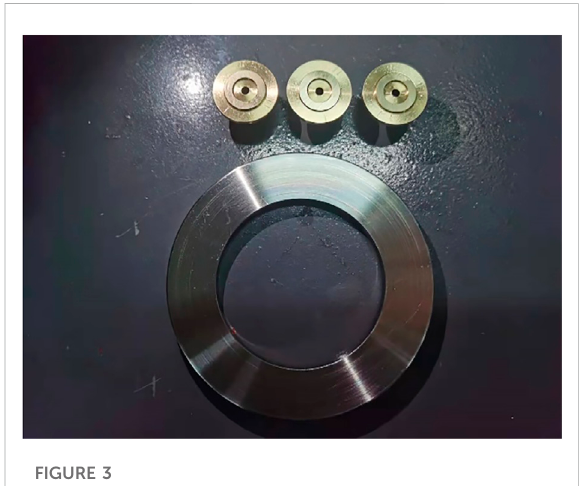
FIGURE 3 Specimen for simulation.